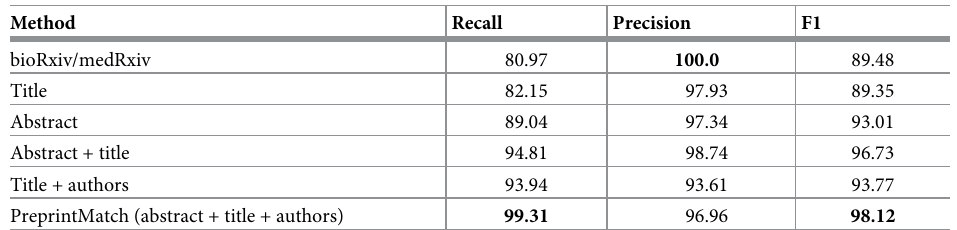
Table 1. Preprint matching method comparison on test set.